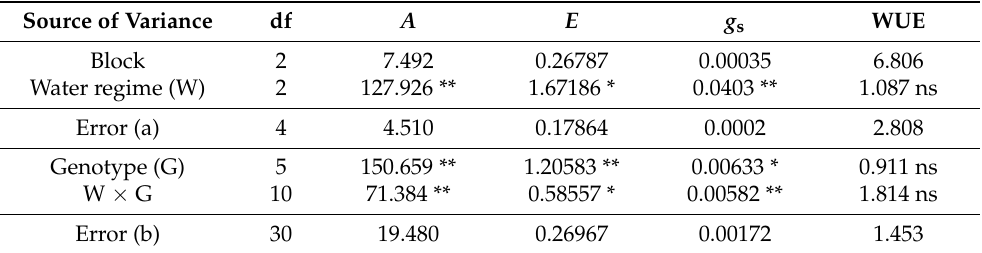
Table 5. Mean squares for net photosynthetic rate ( A ), transpiration rate ( E ), stomatal conductance ( g s ) and water use efficiency (WUE) of six sugarcane genotypes under early drought conditions (determined four months after planting).